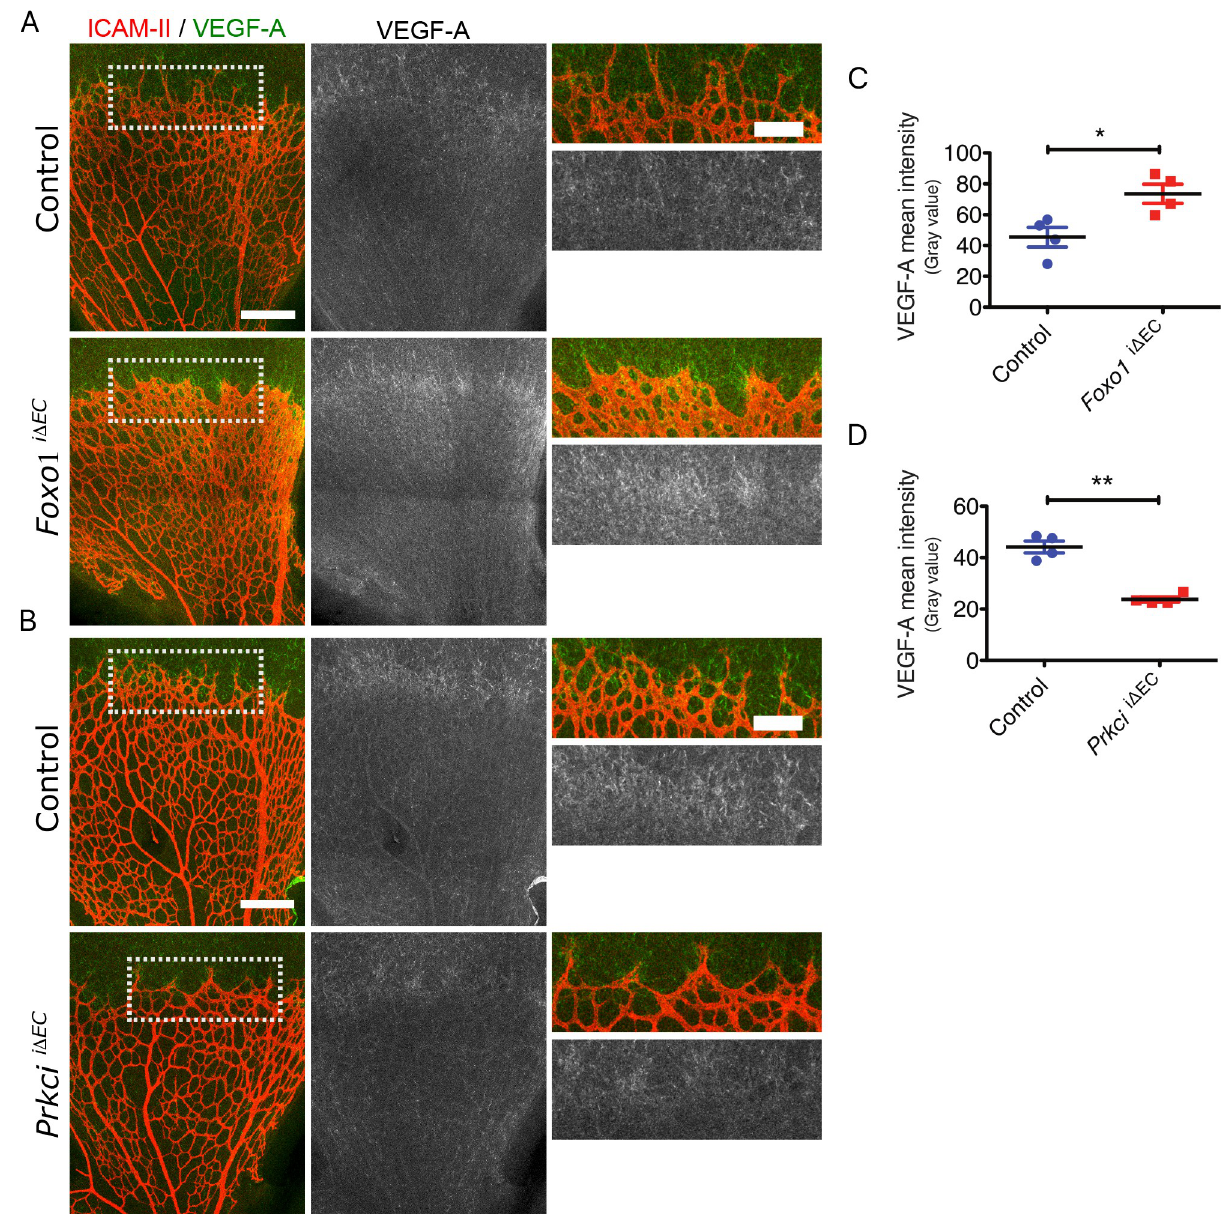
Fig 4. The effect of the hyper- or hypo-branching vasculature on VEGF expression during angiogenesis A) Staining of ICAM-II (red) and VEGF-A (green and gray) in the Foxo1 i Δ EC and B) Prkci i Δ EC mouse retina at P5 and the respective controls; Scale bars represent 200 μ m. Higher magnification images of the indicated areas in the left panel are shown in the right panel; Scale bars represent 100 μ m. C) Quantification of the normalized VEGF-A signal intensity at angiogenic front in Foxo1 i Δ EC and D) Prkci i Δ EC mutant mouse retinas and the respective controls at P5. Data represent mean ± S.E.M. two-tailed unpaired t-test � p < 0.05 �� p < 0.01 (n = 4).